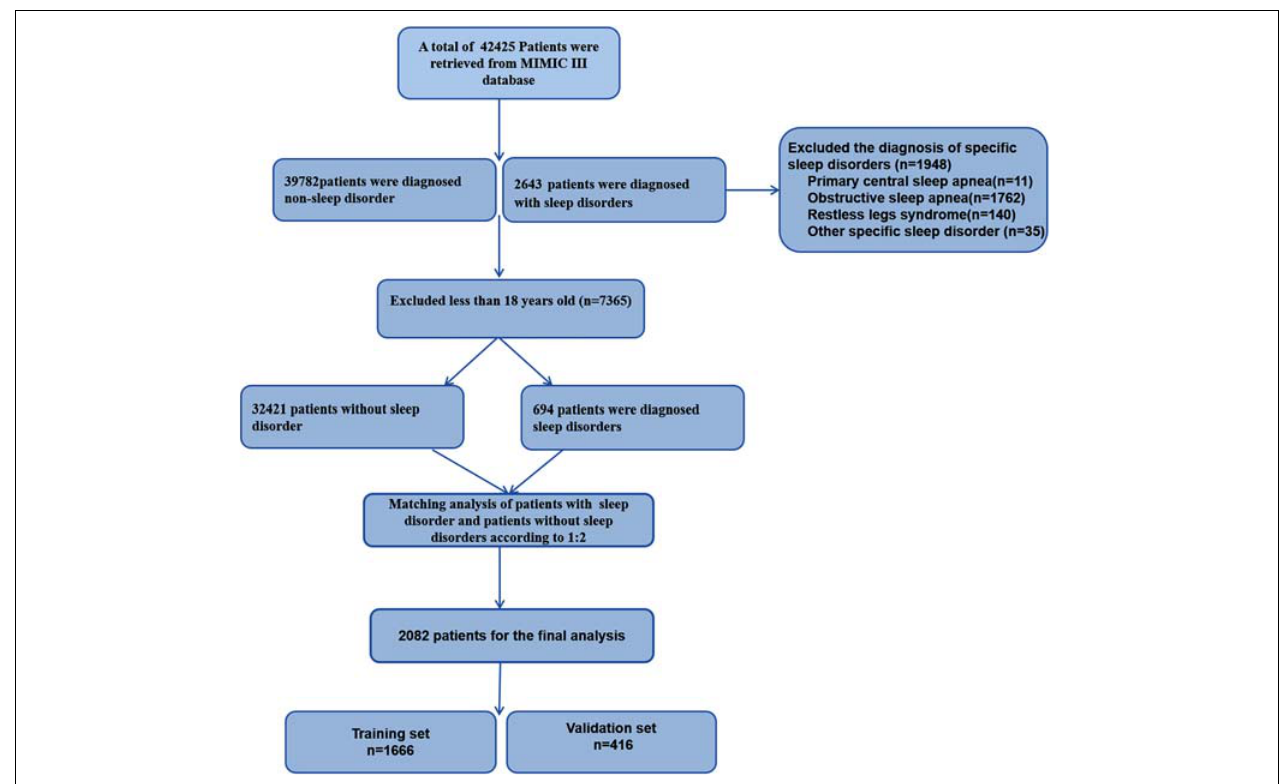
FIGURE 1 | Flow chart of study cohort. MIMIC, Medical Information Mart for Intensive Care.